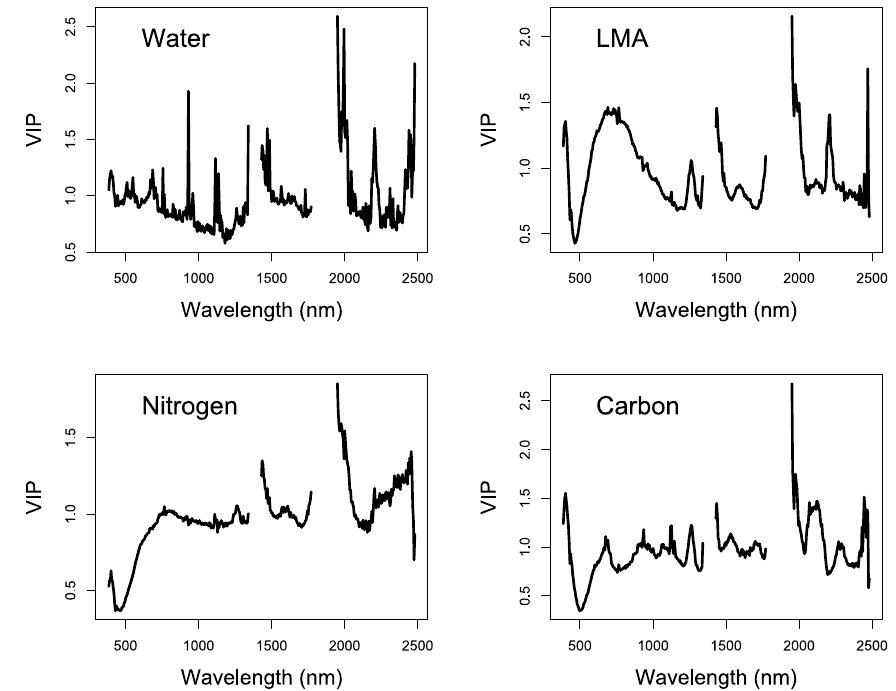
Figure 4. Mean variable importance in projection (VIP) values of the canopy-level PLSR calibration models in sagebrush.